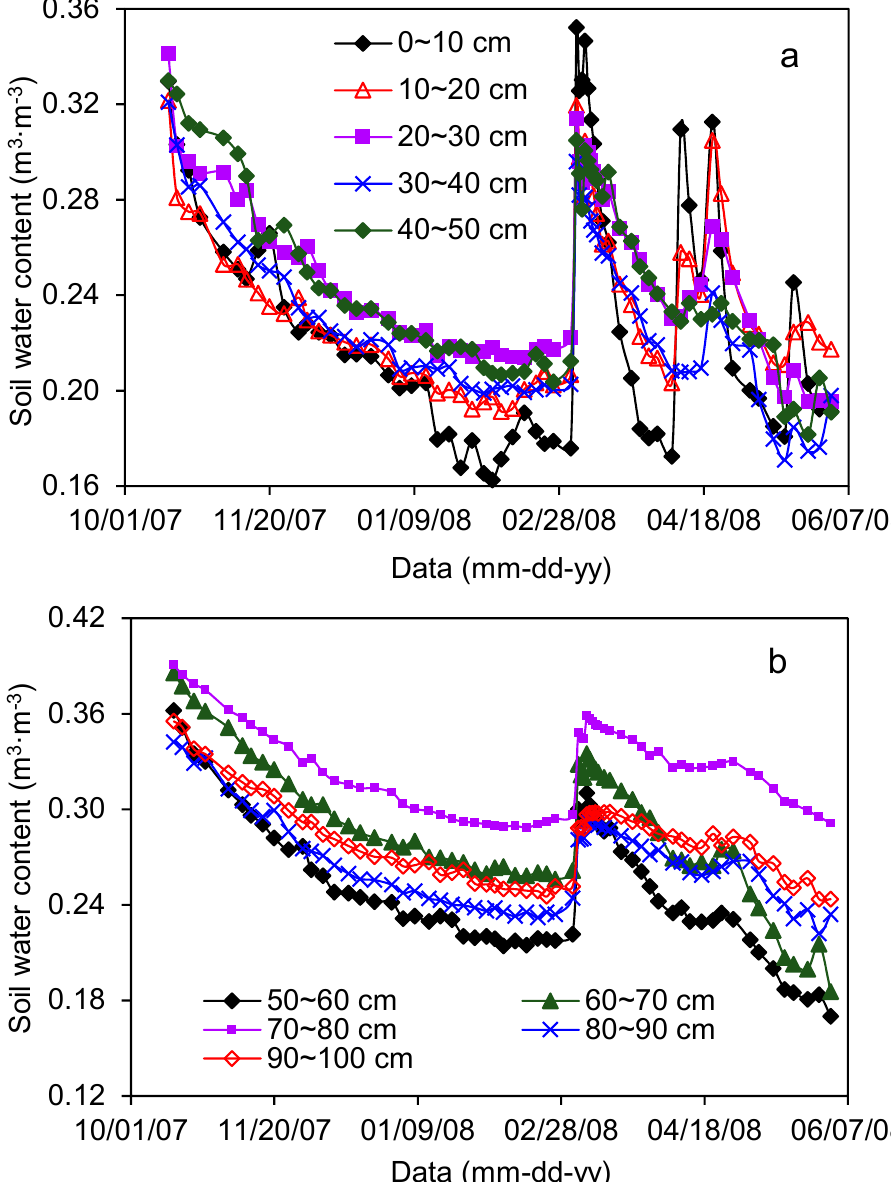
Figure 2. Variations of soil moisture at different layers in the soil profile during the growing season of winter wheat in 2007–2008.